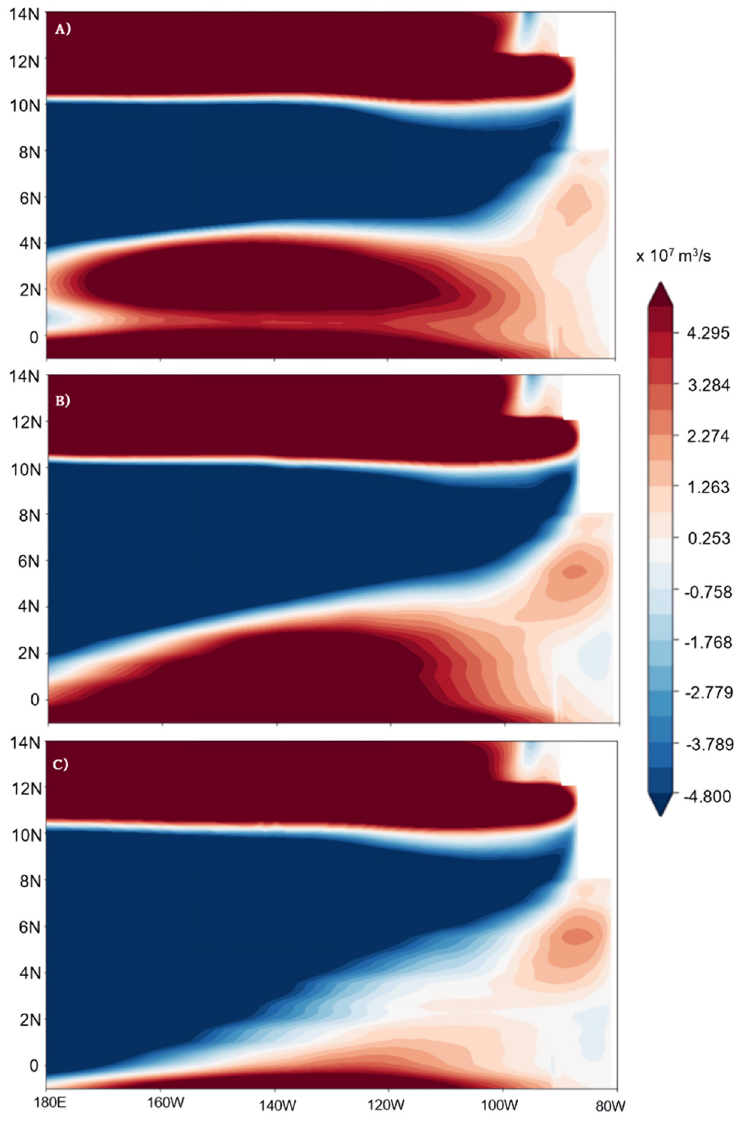
Figure 8. Average of Sverdrup balance (SB) in 10 7 m 3 /s during the winter of El Niño events of the ( A ) CP type, ( B ) MIX type, and ( C ) EP type. The colors red and blue represent east and west transport flow, respectively.